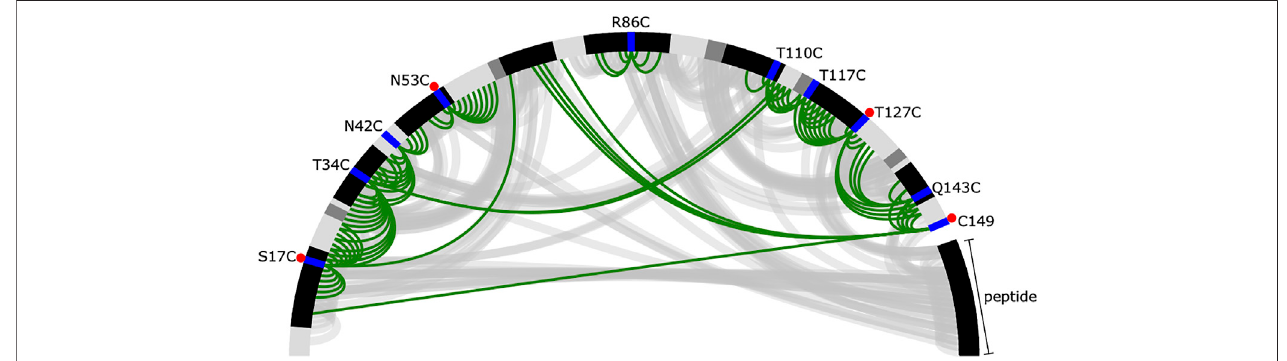
FIGURE2| SummaryofshortdistancesfromthereferencecrystalstructureandinferredfromthePREdata.Theproteinandpeptidebackbonesarerepresentedin a half-circle where the colour depends on the secondary structural element (black — helix, dark grey — extended, light grey — loop). The spin-label locations are shown in blue.Areddotindicatestheexperimentwasperformedwithlabelledpeptide.Shortdistances[( I,j) pairswhere | i − j | > 4and r C α ij < 7 . 6Å]derivedfromthecrystalstructure areshownasgreyarcs.Shortdistances( r label − NH ij